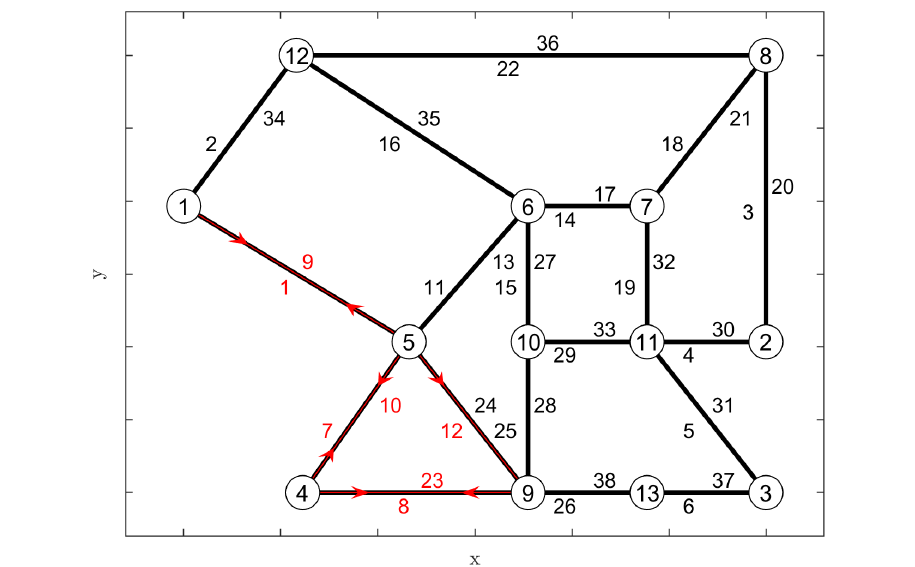
Figure 3. Perturbation considered in the Nguyen-Dupuis network. Red arrows represent the links that are damaged.